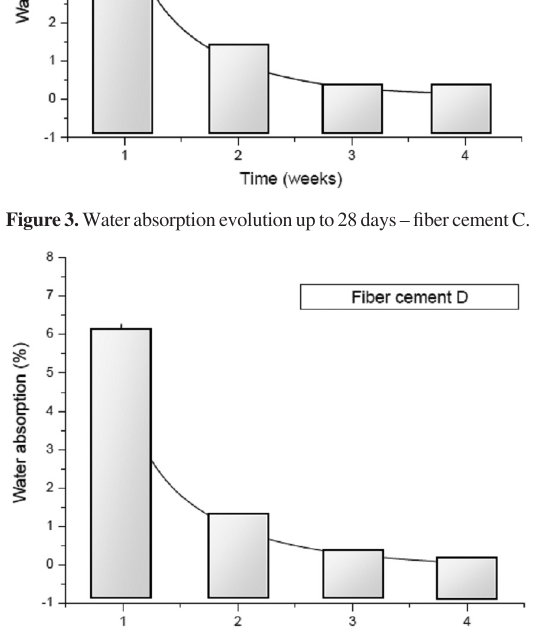
Figure 4. Water absorption evolution up to 28 days – fiber cement D.